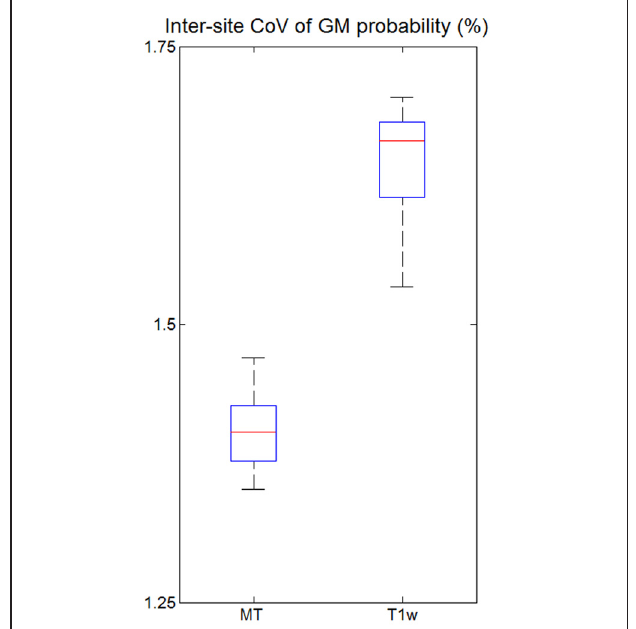
FIGURE 6 | Inter-site coefficient of variation (CoV) of gray matter (GM) probabilities for all five volunteers across the three different sites. CoV was measured within the cortex as determined by thresholding the GM probability map ( p > 0 . 9). For explanation of the whisker plot, see Figure 3 .